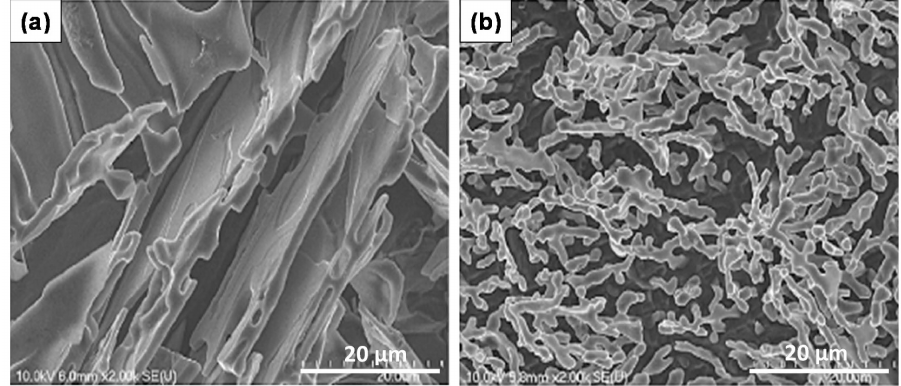
Figure 8. Scanning electron-micrographs of binary Al-7%Si: ( a ) graphite mold, non-modified; ( b ) graphite mold, modified with 54 ppm Sr [20].